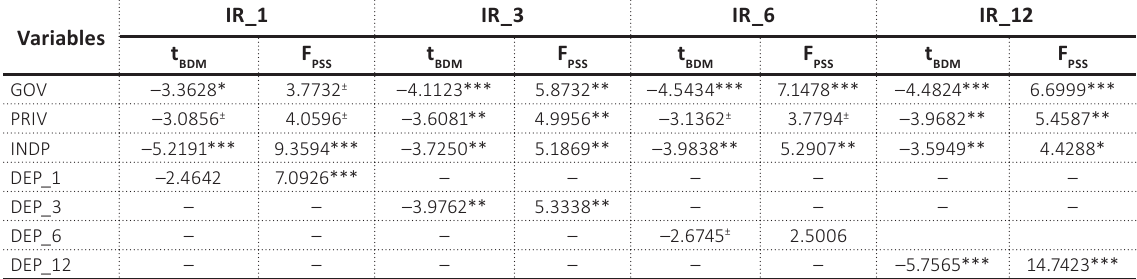
Table 3. Bound test for asymmetric cointegration